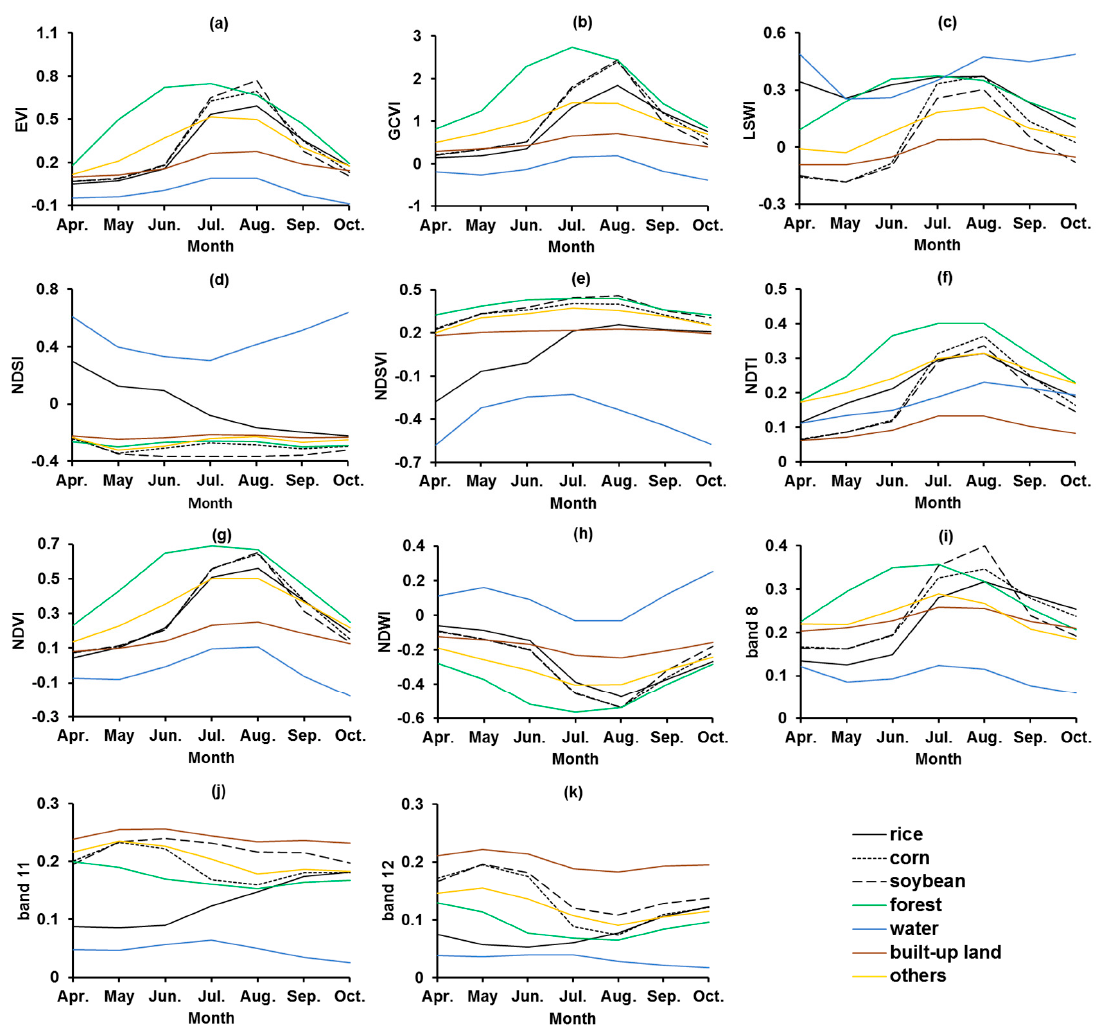
Figure 4. Time series profiles of major crops (corn, rice, and soybean) and other land cover classes (forest, water, built-up land, and others) for 11 vegetation indices and three bands. Panels from ( a ) to ( k ) represent EVI, GCVI, LSWI, NDSI, NDSVI, NDTI, NDVI, NDWI, band 8, band 11, and band 12, respectively. The horizontal and vertical axes refer to the month of year and the spectral index or band values,